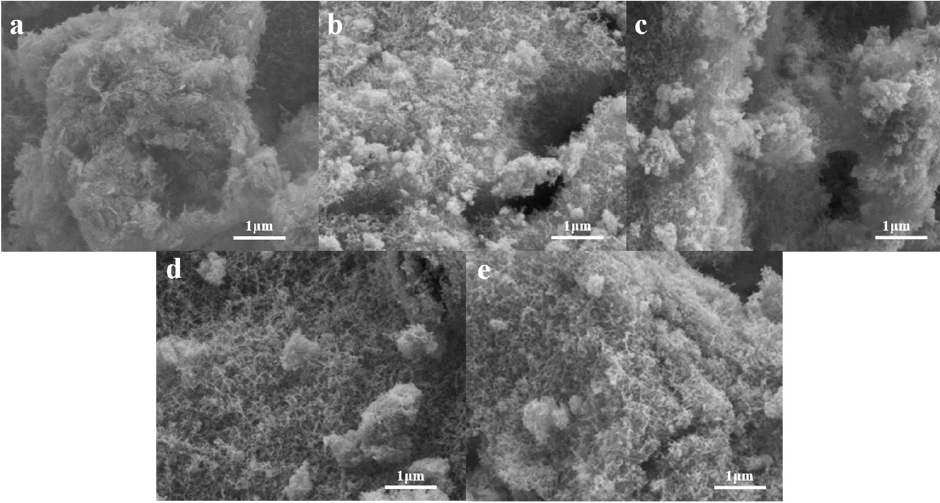
Figure 3. Scanning electron microscopy (SEM) images of AS0 after heat treatment from 20 to 1200 °C: ( a ) AS0-20, ( b ) AS0-600, ( c ) AS0-800, ( d ) AS0-1000, ( e ) AS0-1200.